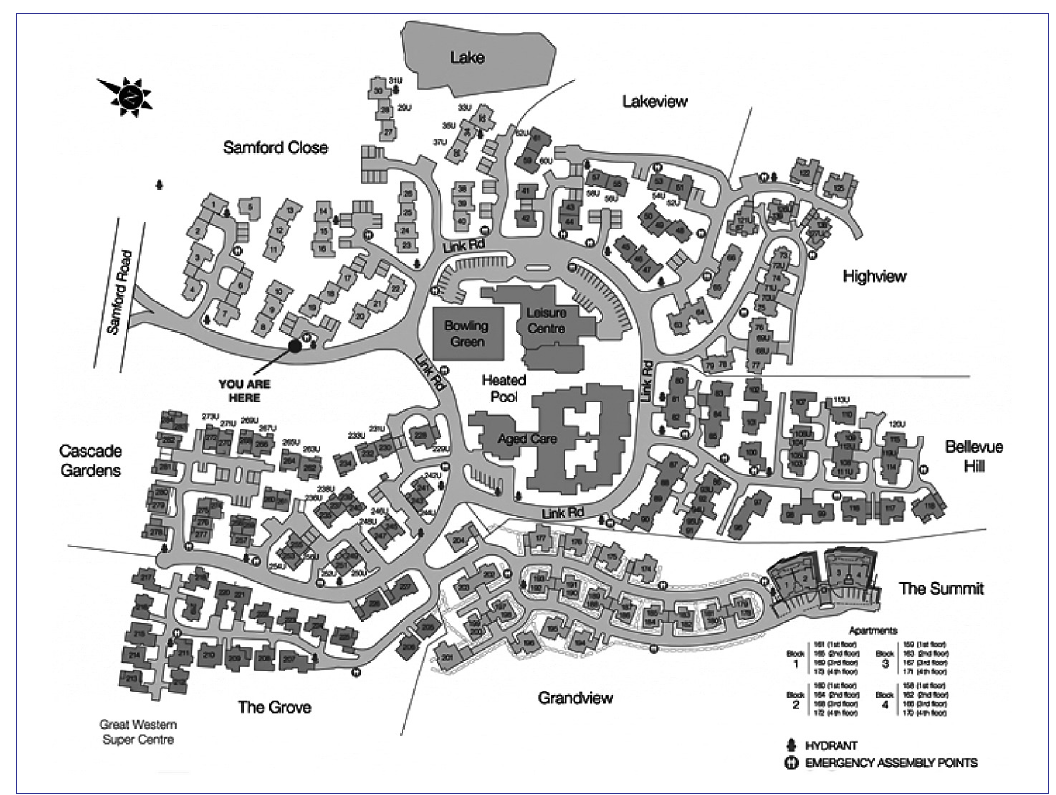
Fig. 2. Site plan of Keperra Sanctuary, Courtesy of Keperra Sanctuary, Lend